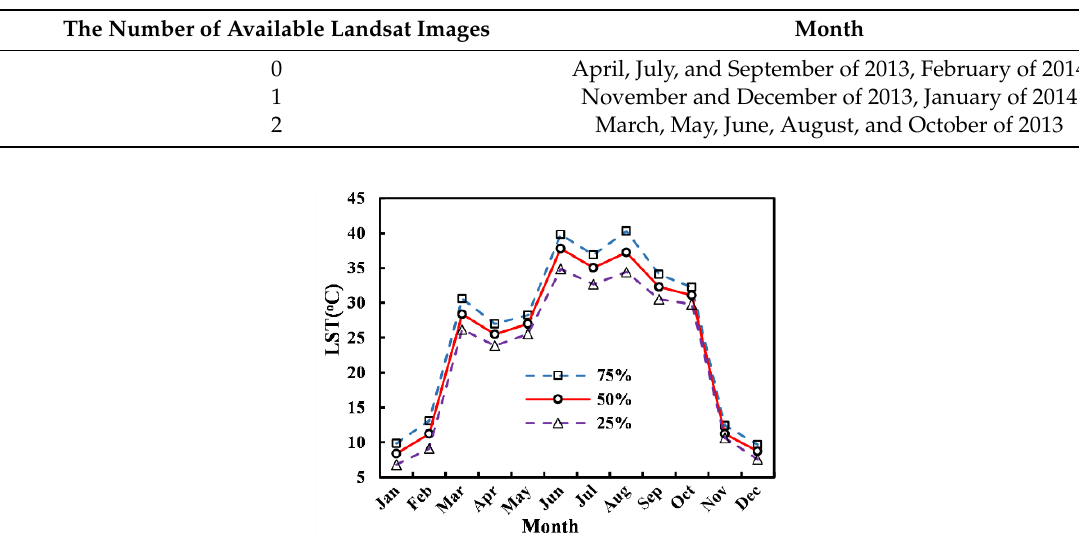
Table 4. The number of available Landsat images in each month of 2013. The Number of Available Landsat Images